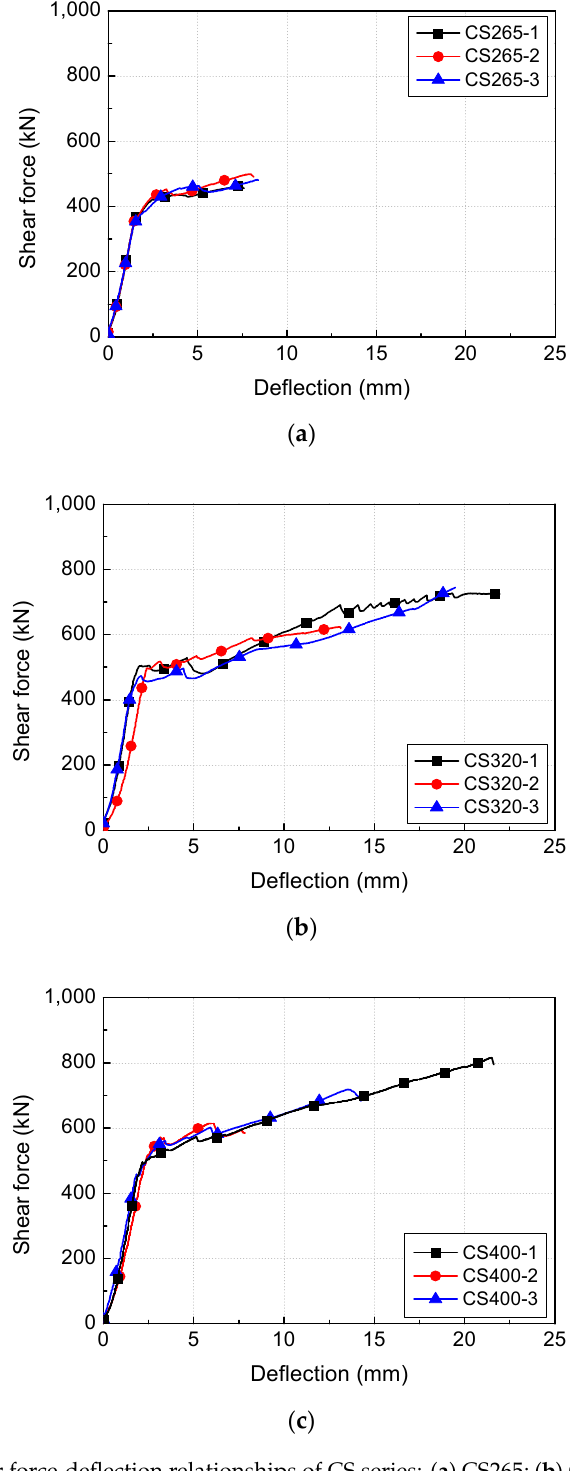
Figure 8. Shear force-deflection relationships of CS series: ( a ) CS265; ( b ) CS320; ( c ) CS400.